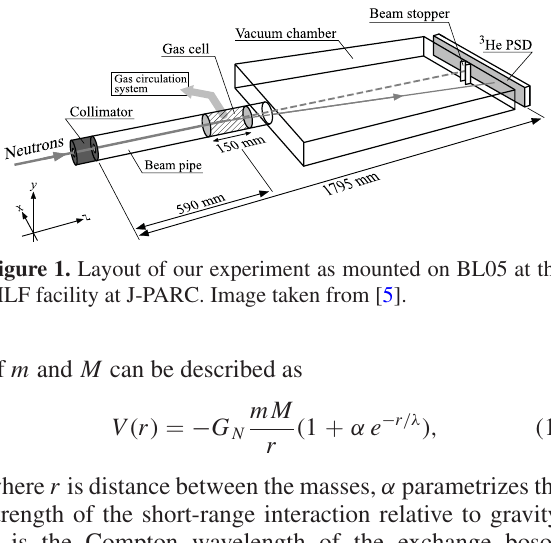
Figure 2. Beam intensity profile during 150 kW proton beam power operation on BL05 at MLF.